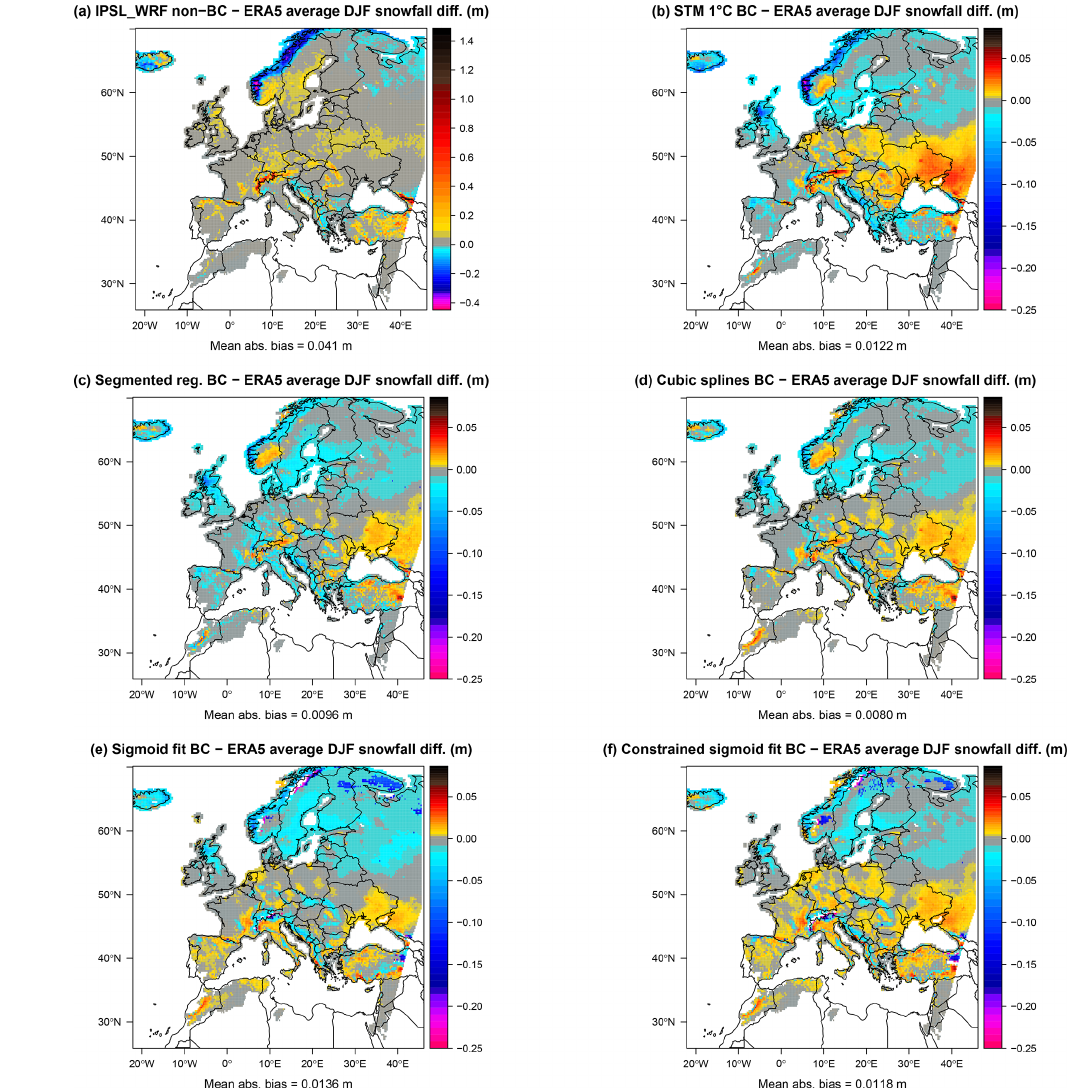
Figure 8. Difference in meters between the statistical approximation and reanalysis average of DJF snowfall for the years 1979–2005. The IPSL_WRF model (a) , 1 ◦ C STM (b) , segmented logit-linear regression (c) , cubic spline regression (d) , unconstrained (e) , and constrained sigmoid function (f) are